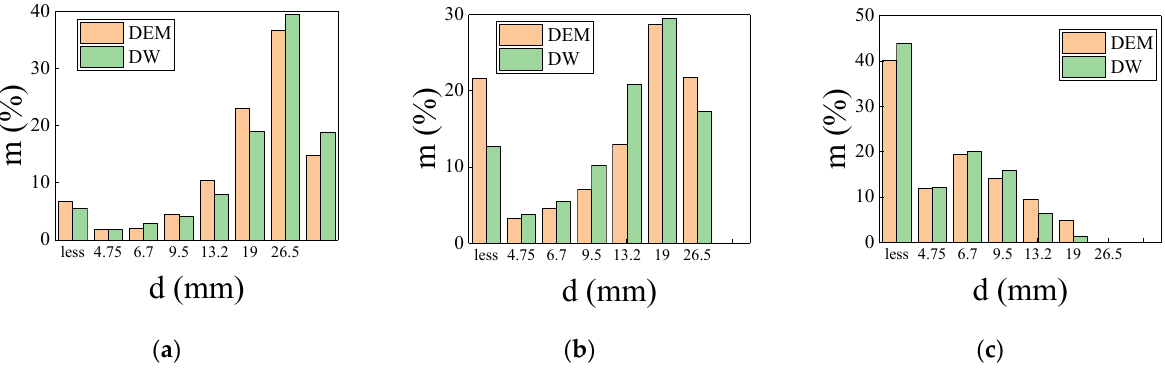
Figure 12. Mass percentage comparison among different particle sizes. ( a ) E = 0.1 kwh/t; ( b ) E = 0.25 kwh/t; ( c ) E = 1 kwh/t. Table 6. 40 mm × 40 mm × 39 mm particle composition. Sieving Size (mm)